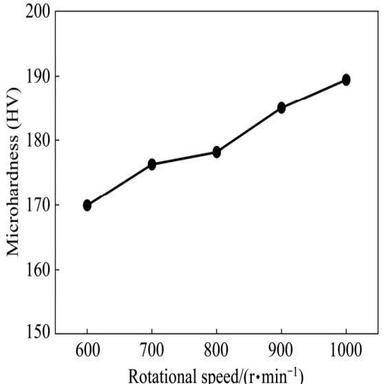
Effect of rotational speed on microhardness of composite coating